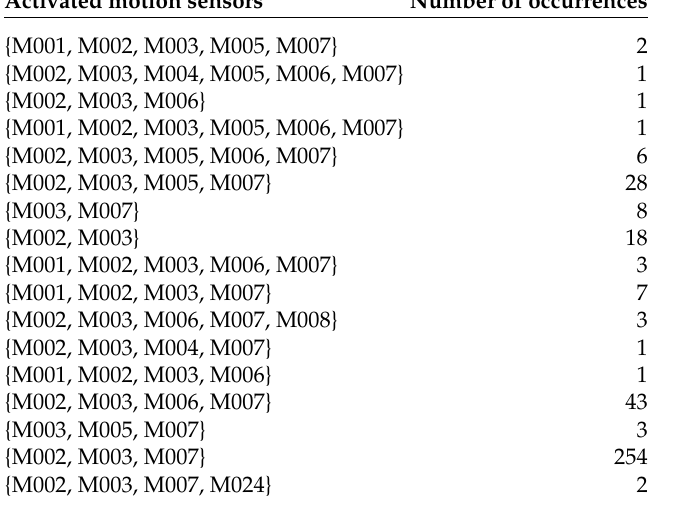
Figure 4. Sets of motion sensors activated by the sleeping activity. The analysis was performed on the Aruba data